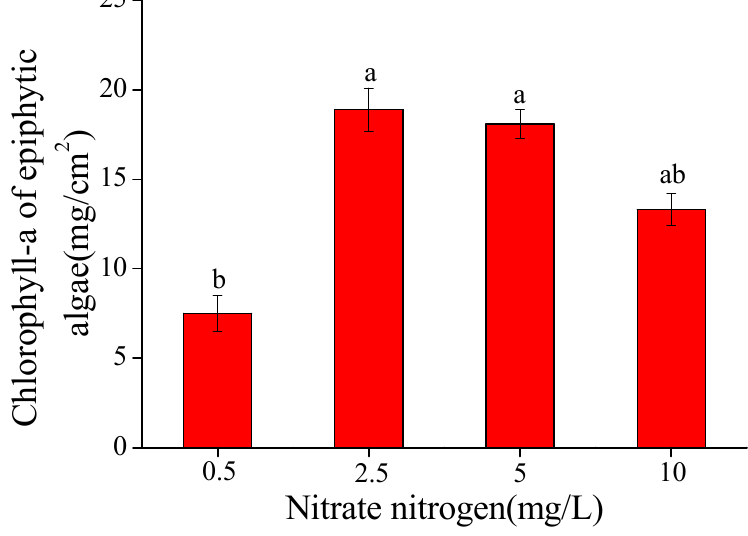
Figure 2. Chlorophyll-a content of epiphytic algae per unit leaf area of V. natans (mean ± SE, n = 3) in the epiphytic algae group under four nitrate-N concentrations. Bars with different letters indicate significant differences among treatments ( p < 0.05).